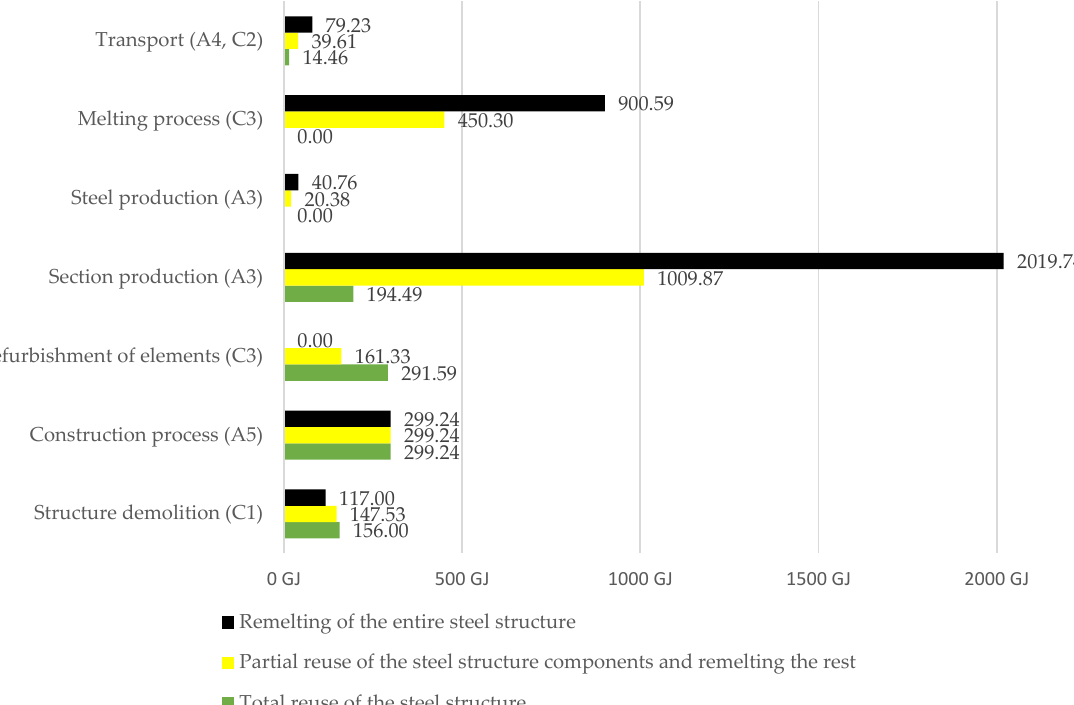
Figure 12. Primary Energy Use in processes [GJ].